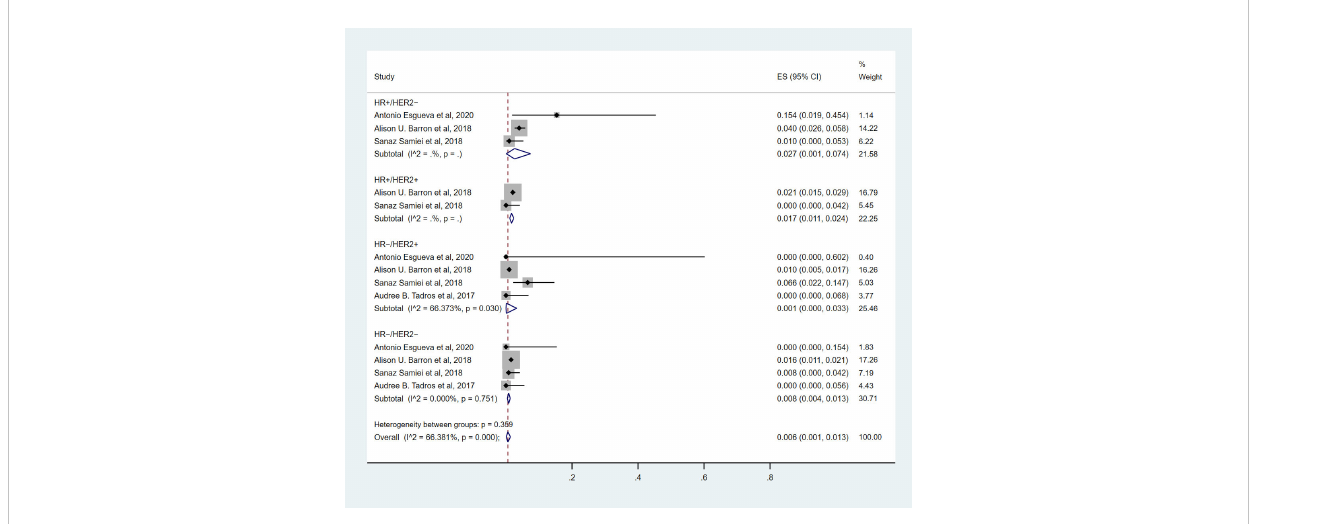
FIGURE 3 The overall pooled ypN+ rate of cN0 patients who achieved bpCR for different breast cancer subtypes with T1-T2 tumors. HR, hormone receptor; HER2, human epidermal growth factor receptor 2. ES, effect size. CI, con fi dence interval. Effect size was used to estimate the ypN+ rate of each study. Con fi dence intervals determine the consistency and reliability of the mean estimated effect size. Diamonds indicate effect size.